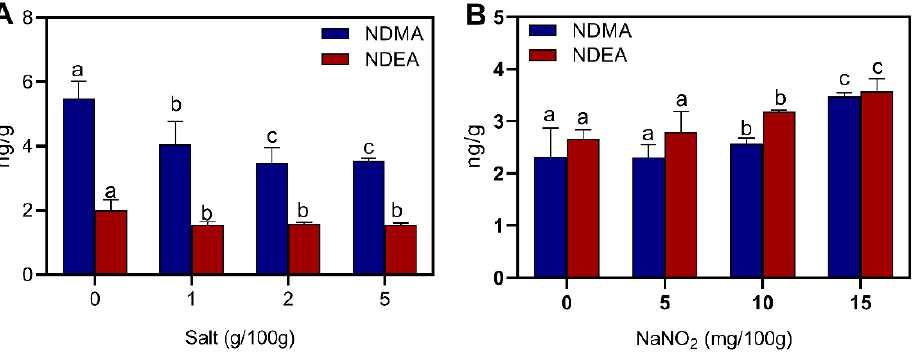
Figure 6. Effect of additives on NDMA and NDEA: ( A ) salt; ( B ) nitrite. Different letters above the bars indicate significant differences (n = 3, p < 0.05). N-nitrosodimethylamine (NDMA) and N-nitrosodiethylamine (NDEA).